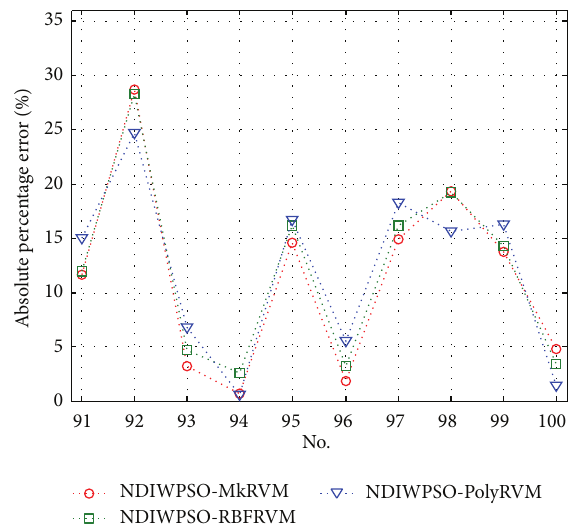
Figure 3: The comparison of the absolute percentage prediction errors for kurtosis of bearing vibration signal among NDIWPSO- MkRVM, NDIWPSO-RBFRVM and NDIWPSO-PolyRVM in case